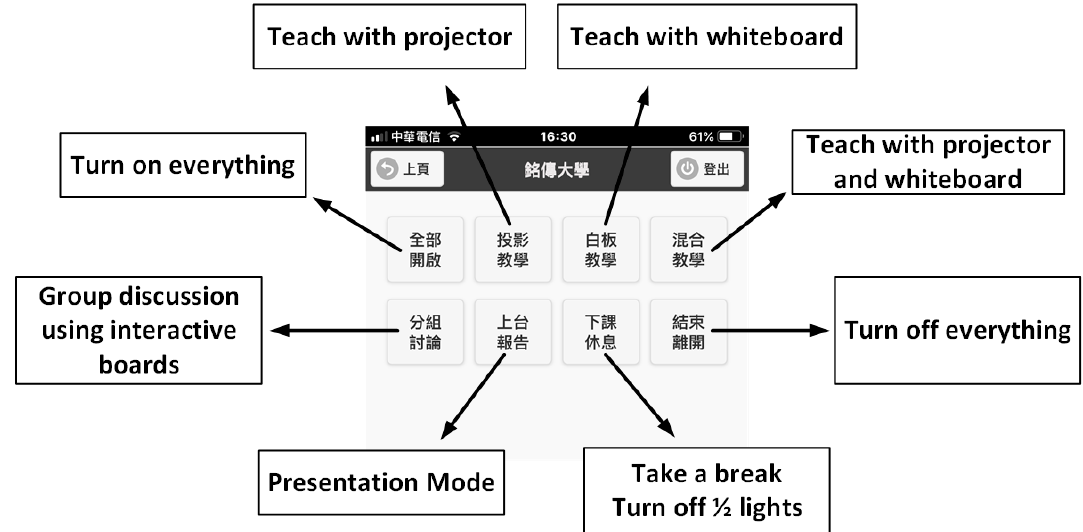
Figure 12. A mobile phone application for teachers to set devices to predefined configurations in smart classrooms for different teaching scenarios. As the explanations in this figure, the functions of the buttons in the top line from left to right are ‘Turn on everyyhing’, ‘Teach with projector’, ‘Teach with whiteboard’, and ’Teach with projector and whiteboard’. The functions of the buttons in the bottom line from left to right are ‘Group discussion using interactive boards’, ‘Presentation mode’, ‘Take a break’, ‘Turn off everything’.